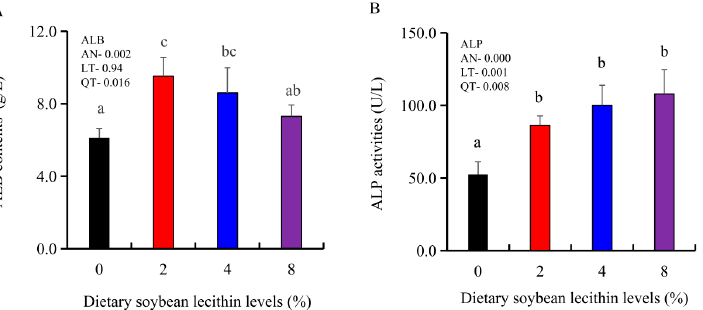
Figure 2. Effect of dietary soybean lecithin on serum albumin (ALB) contents ( A ) and alkaline phosphatase (ALP) activities ( B ) of juvenile largemouth bass. Bars with different letters indicate significant differences ( p < 0.05), while that with the same letter or no letter superscripts indicate no significant differences ( p > 0.05), AN: ANOVA, LT: linear trend, QT: quadratic trend.